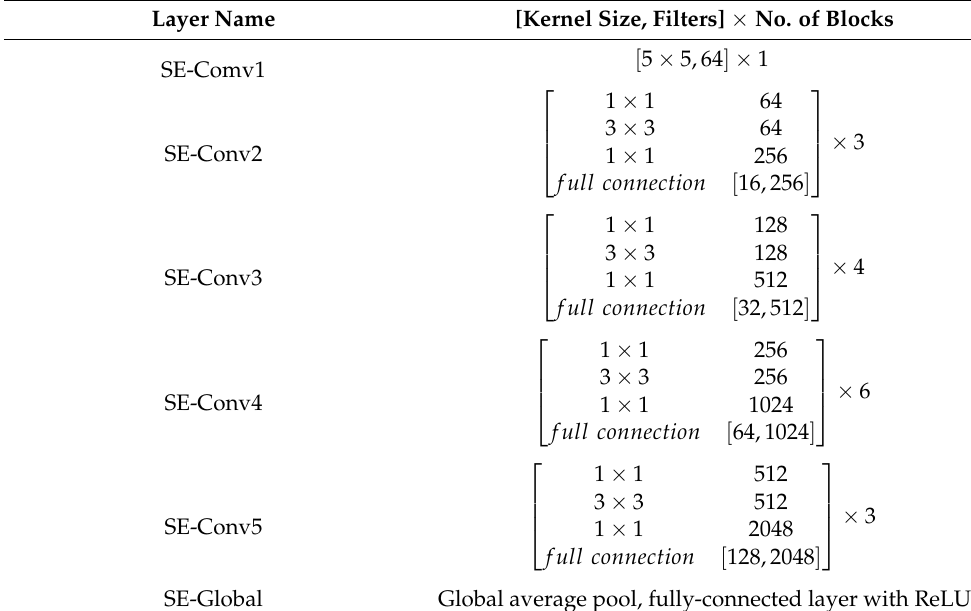
Table 1. The attention-based DCNN for estimation of the guess of the initial MSEM. Layer